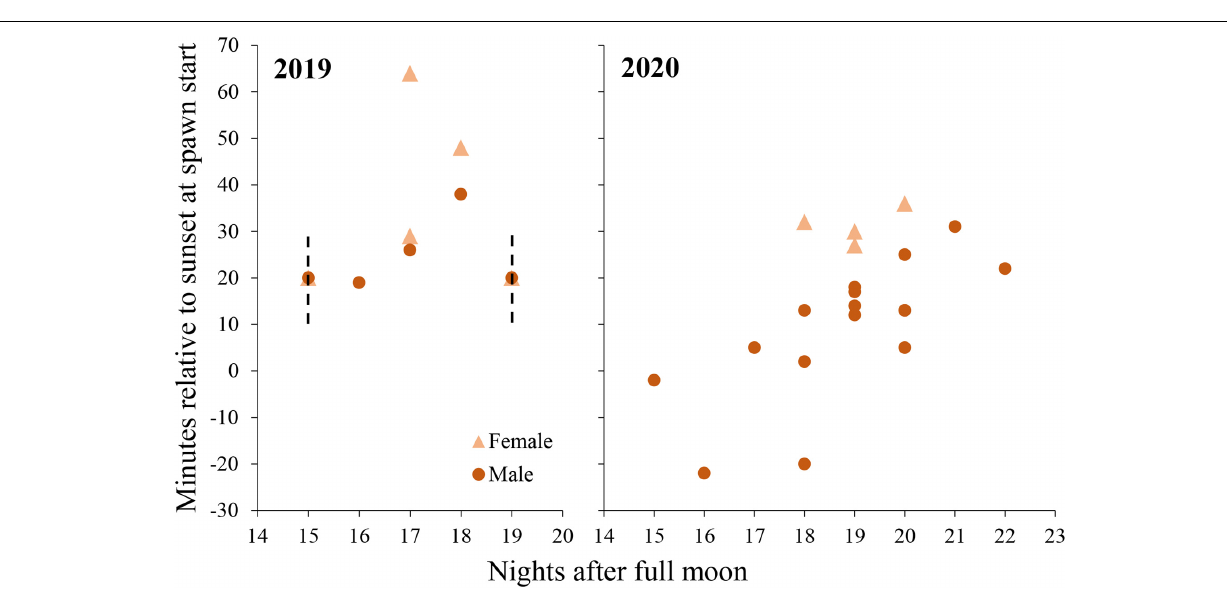
FIGURE 6 | Daily spawn timing in M. meandrites colonies held a controlled system in 2019 (left) and 2020 (right). Each point represents a single colony. Dashed lines represent periods in which spawning occured without exact times recorded, yet the event is known to have been within the timeframes depicted. In both cases, at least one male and one female colony